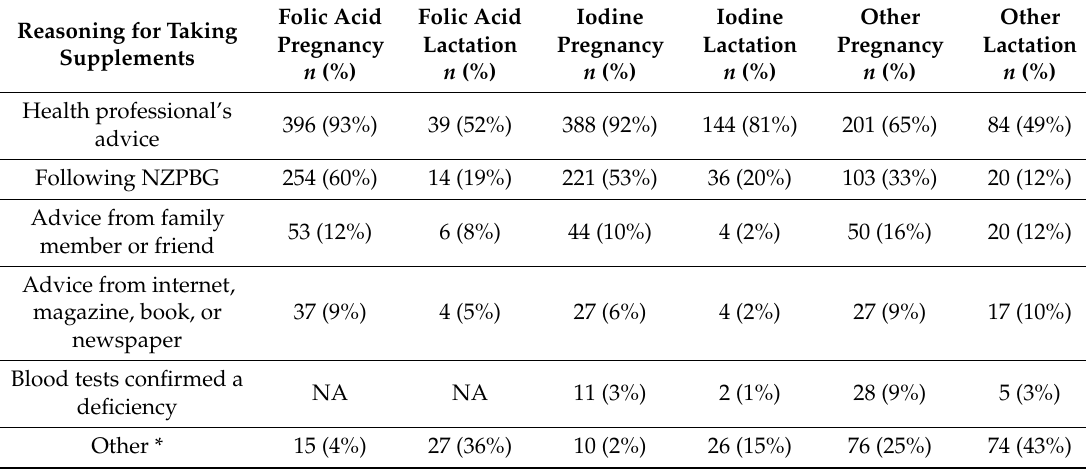
Table 6. Reasoning for taking supplements in pregnancy and